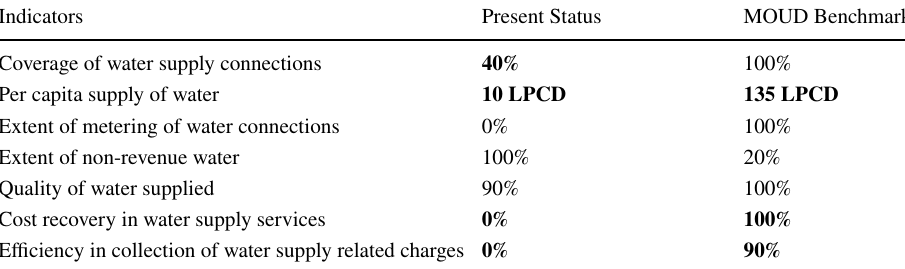
Table 5 AMRUT project target. Source AMRUT project report, DM (2015)